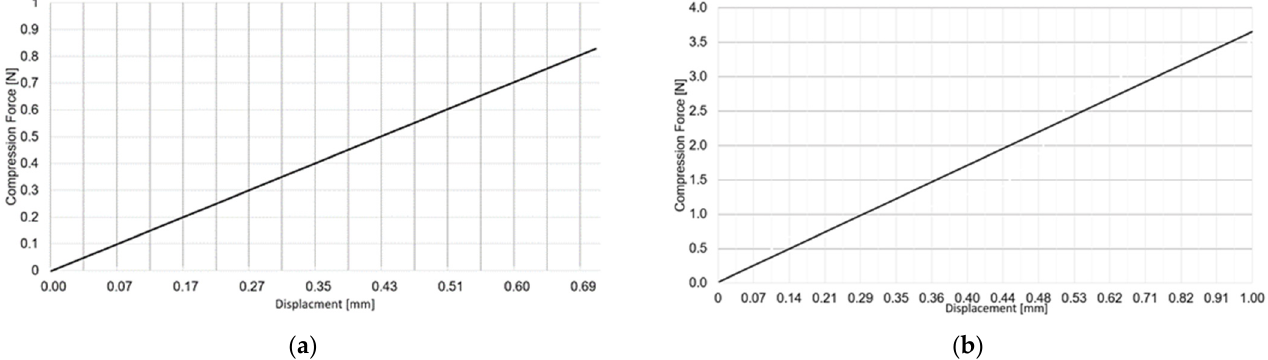
Figure 16 . Force-displacement diagram for: ( a ) transverse and ( b ) longitudinal compression test .